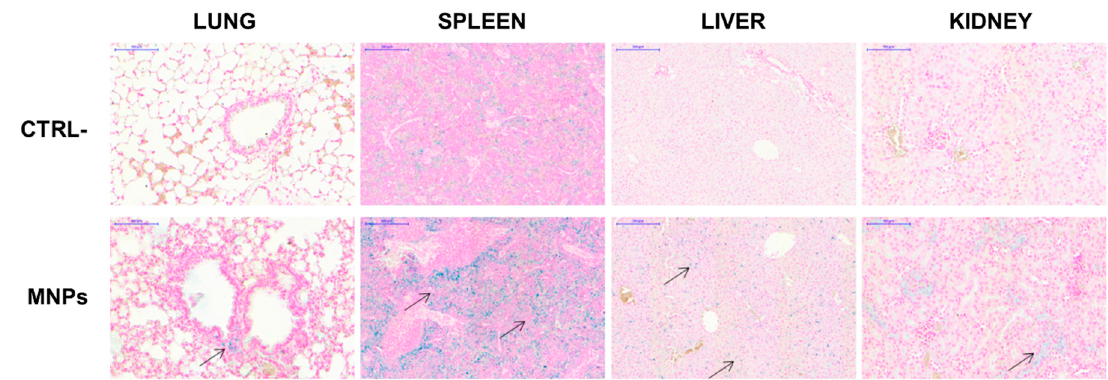
Figure 11. In vivo distribution of MNPs. NOD / SCID- γ null mice were injected in the tail vein with MNPs (10 µ g / g) in 100 µ L PBS. After 3 days these mice, together with untreated control mice, were euthanized and their organs were recovered and processed for histological analysis after staining with Prussian blue. Arrows indicate iron deposits stained in blue.